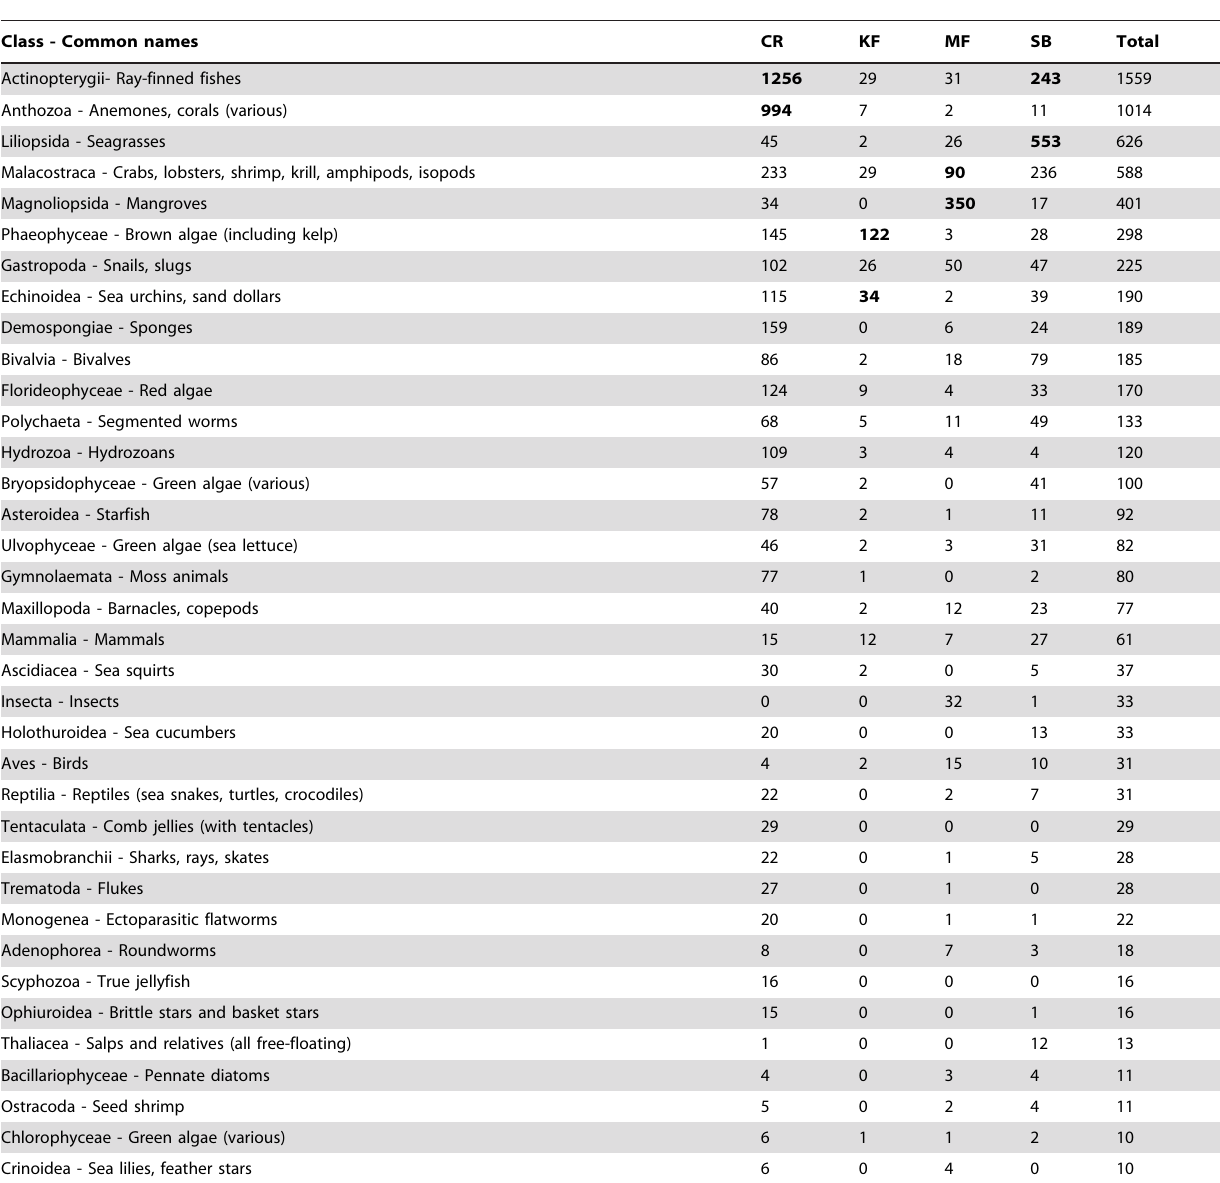
Table 2. Numbers of research papers by taxonomic class for four marine